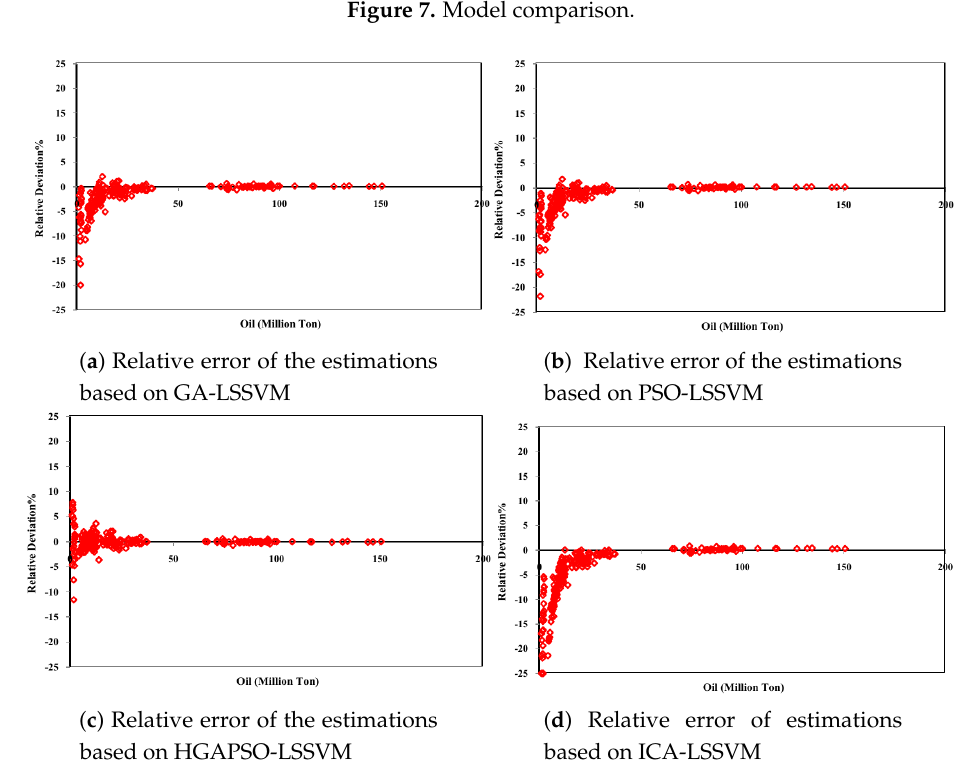
Figure 8. Relative error per